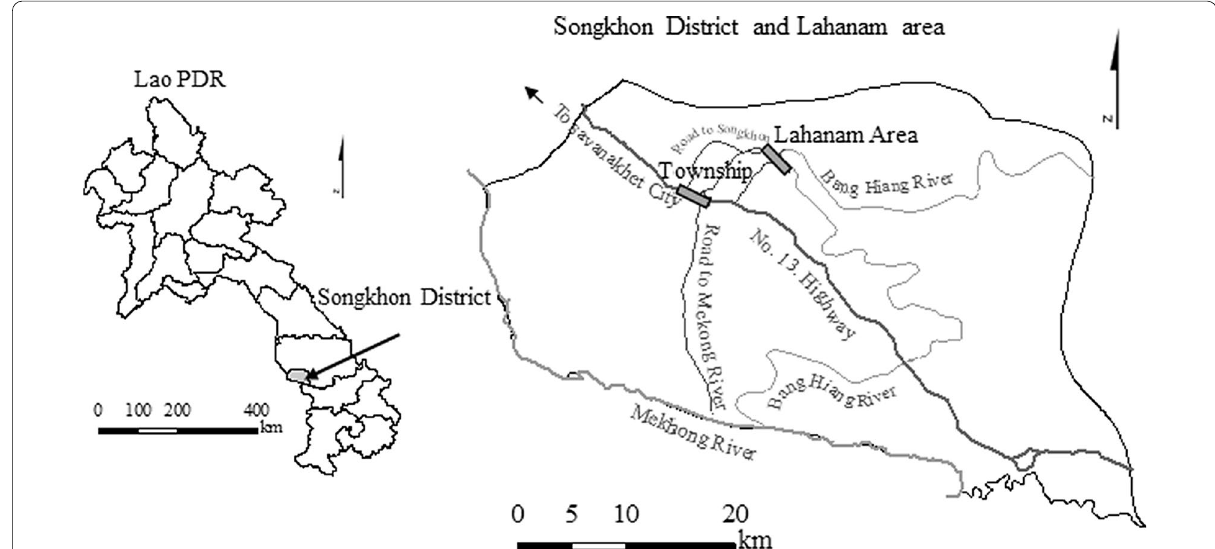
Fig. 1 Lahanam area in Songkhon District, Lao PDR. The target village, located inside the rectangular shape labeled as Lahanam Area on the map, is situated along the west bank of the Bang Hiang River (This map was created by the